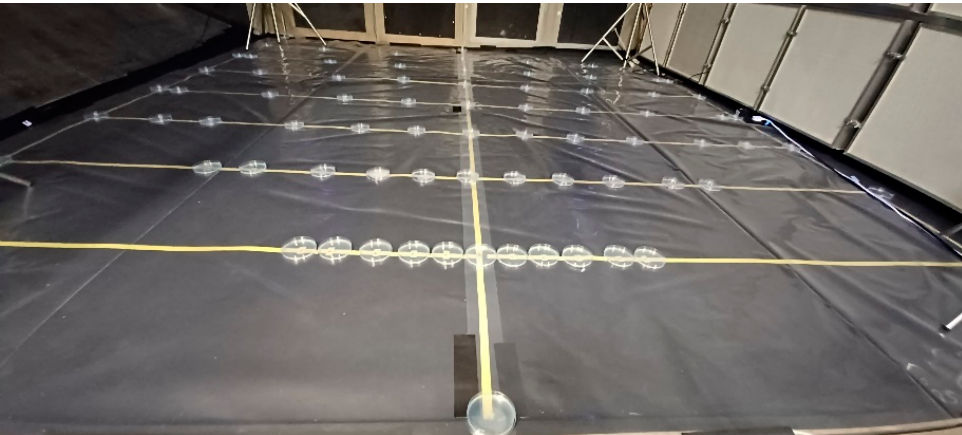
Figure 3. Test room with marked grid pattern and agar settle plates.